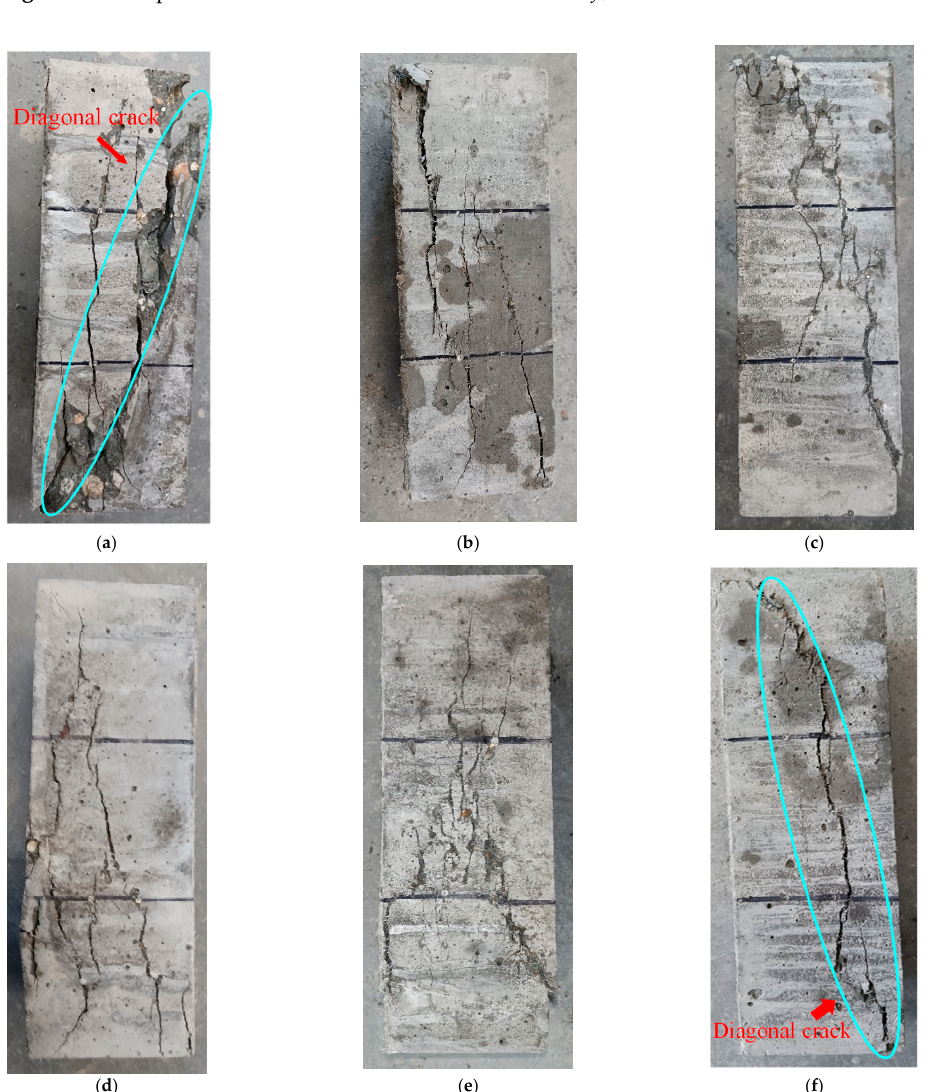
Figure 16. Failure performances of SWSSC specimens after the axial compressive test: ( a ) NF; ( b ) POM-0.2; ( c ) POM-0.4; ( d ) POM-0.6; ( e ) POM-0.8; ( f ) POM-1. Table 9. Results of the axial compressive tests of SWSSC with different mixes.